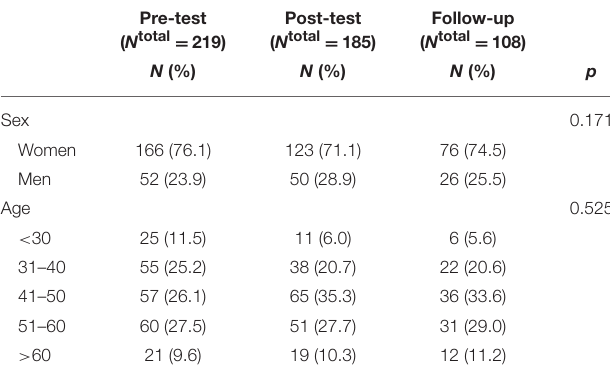
TABLE 1 | Study sample: descriptive statistics of the study sample and result of analysis of variance of sample characteristics according to measurement point. Pre-test ( N total =